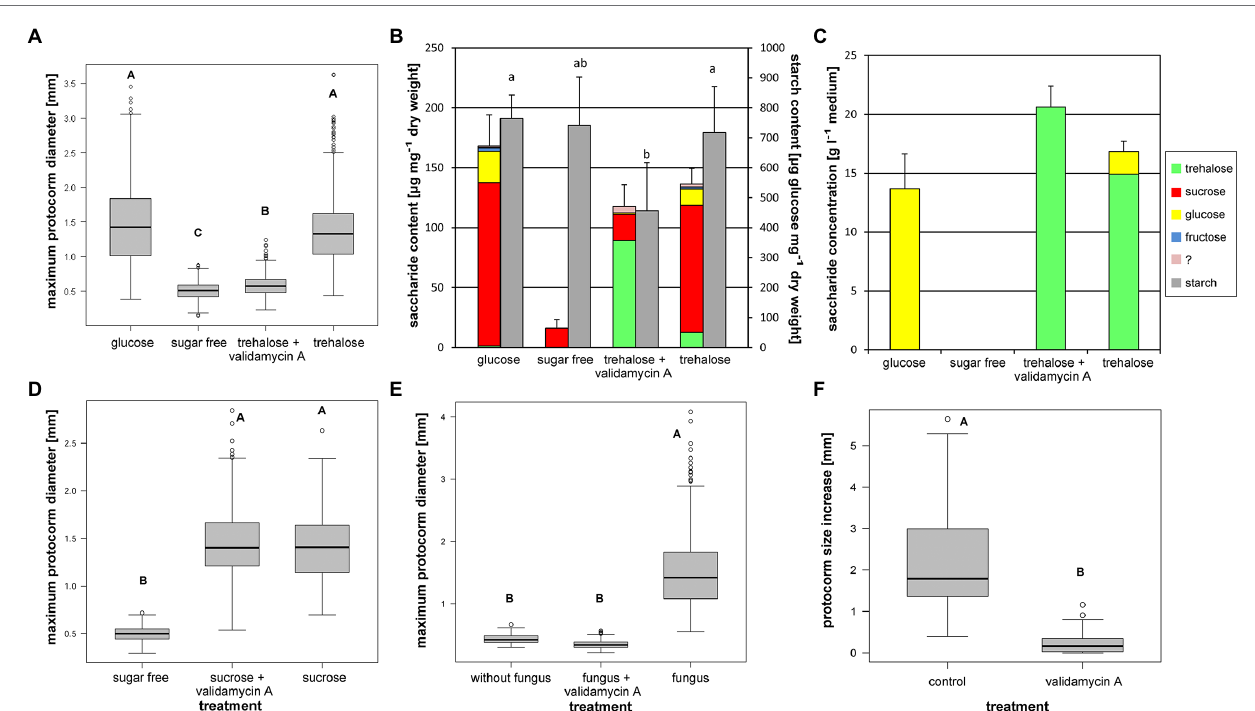
FIGURE 2 | Effect of trehalase specific inhibitor Validamycin A on D. majalis protocorm characteristics. Cultivation on symbiotic medium OMA or asymbiotic medium SMS with 100 mM glucose or 50 mM disaccharides; modified to contain 0 or 150 μ M Validamycin A. Different letters indicate statistically significant differences. (A) Validamycin A inhibits growth of trehalose-supported protocorms (4-month cultivation, medians, Nested ANOVA followed by TukeyC test on log- transformed data). (B) Non-structural carbohydrate contents in protocorms from (A) (mean values and SD of total soluble carbohydrate and starch contents, ANOVA, Tukey–Kramer test. For statistics see Supplementary Table 2 ). (C) Soluble carbohydrate contents in the media after cultivation of protocorms from (A) (mean values and SD of total soluble carbohydrate content, for statistics see Supplementary Table 3 ) (D) Validamycin A has no effect on sucrose-supported protocorms (4-month cultivation, medians, Nested ANOVA followed by TukeyC test on log-transformed data). (E) Validamycin A blocks growth of symbiotic protocorms grown from seeds directly on experimental media (2-month cultivation, medians, Nested ANOVA followed by TukeyC test on log-transformed